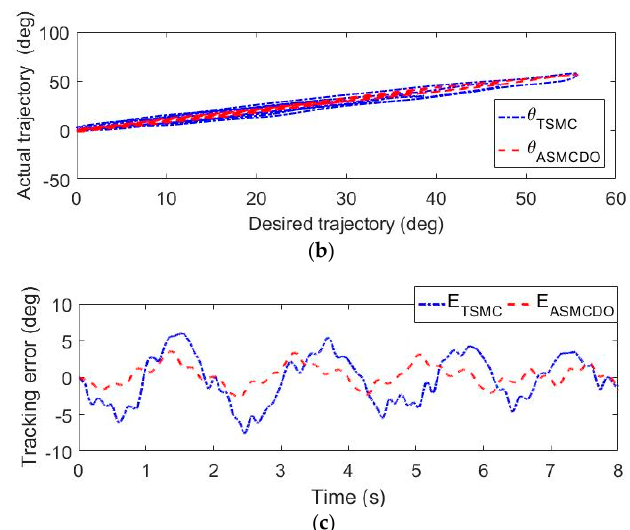
Figure 7. The comparison results of the trajectory tracking experiments for shoulder flexion/extension. ( a ) Time histories of desired displacement and actual displacement. ( b ) Comparison between desired displacement and actual displacement. ( c ) The tracking error of different controllers.